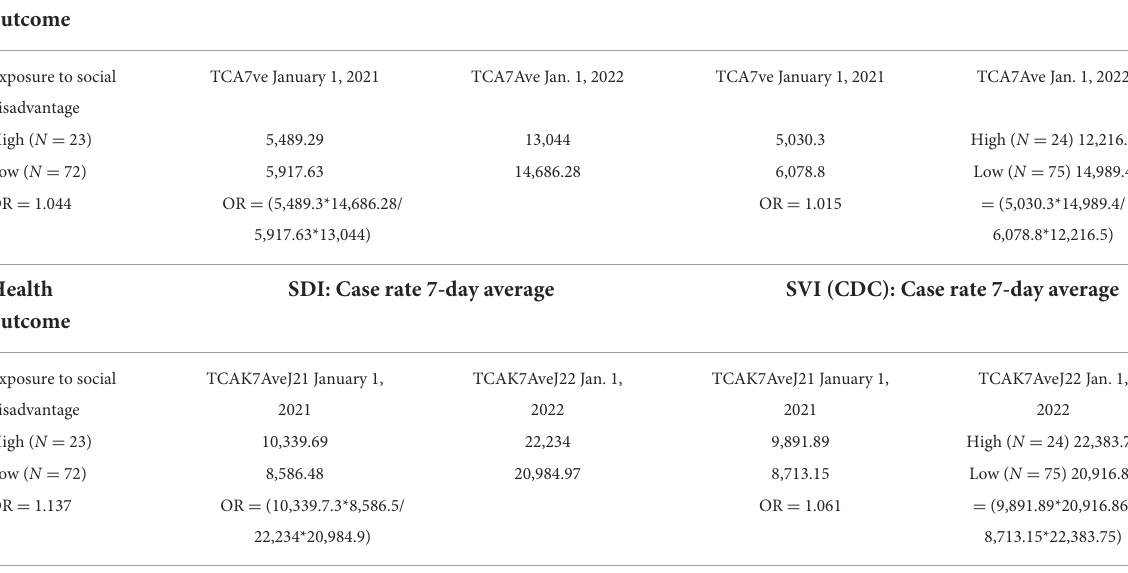
TABLE 3 Odds ratio of case count (7-day average) and case rate (7-day average) for counties with high disadvantage: Results comparison for areas identified with SDI and SVI indices.